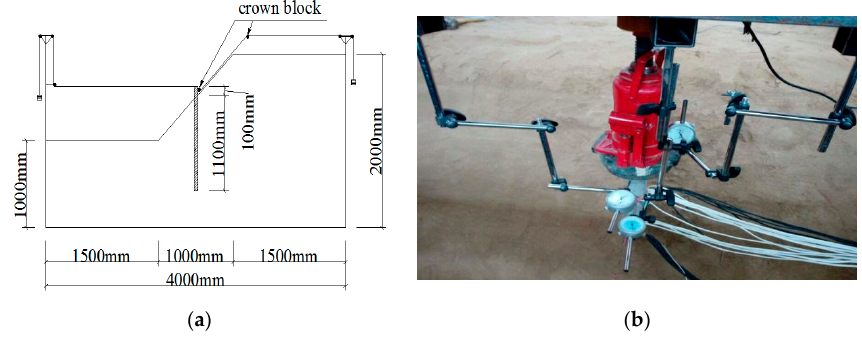
Figure 2. Test of piles on slope: ( a ) test device design; ( b ) installation of test monitoring equipment.